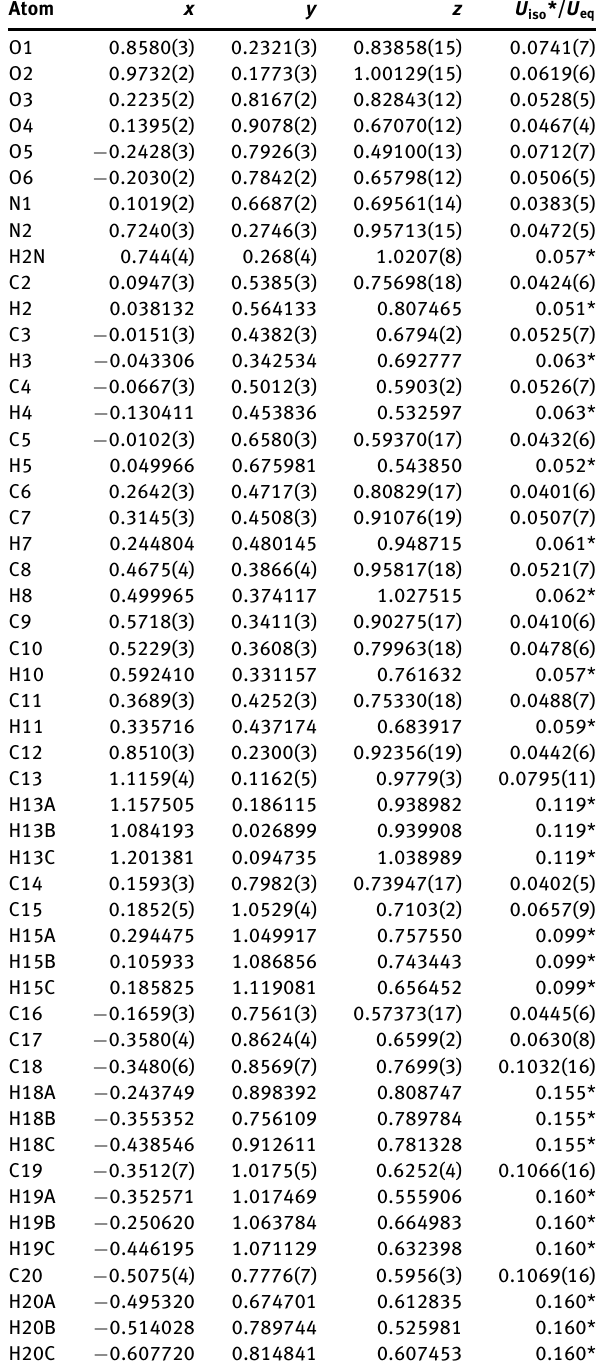
Table 2: Fractional atomic coordinates and isotropic or equivalent isotropic displacement parameters (Å 2